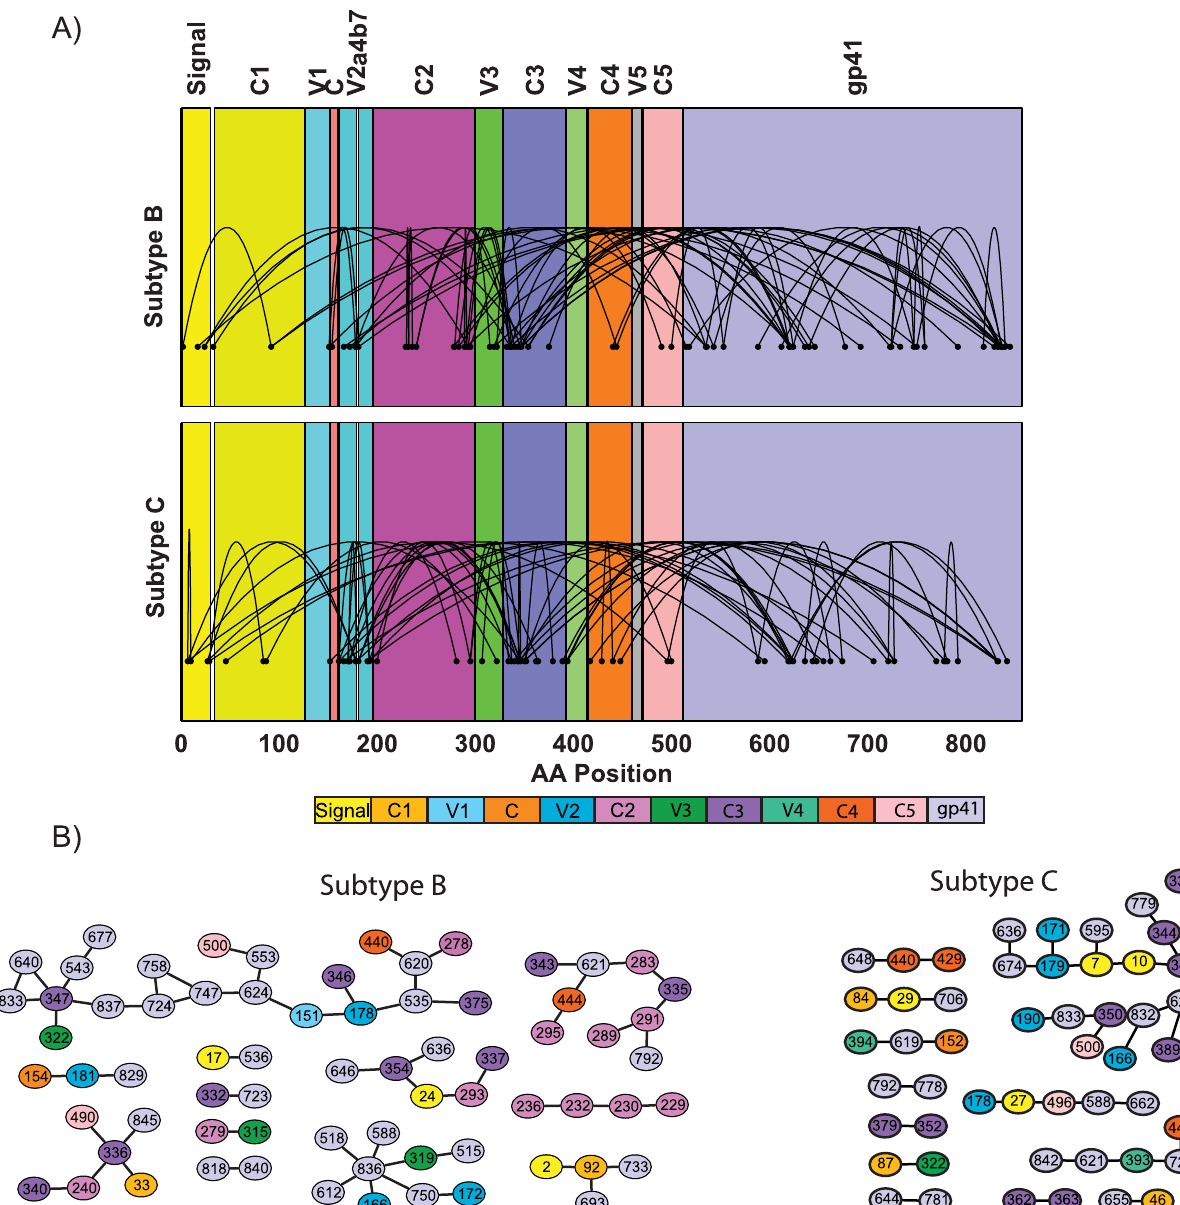
Fig 3. The collection of optimal pairs displayed relative to the domains of Env. A) over a linear representation and B) as